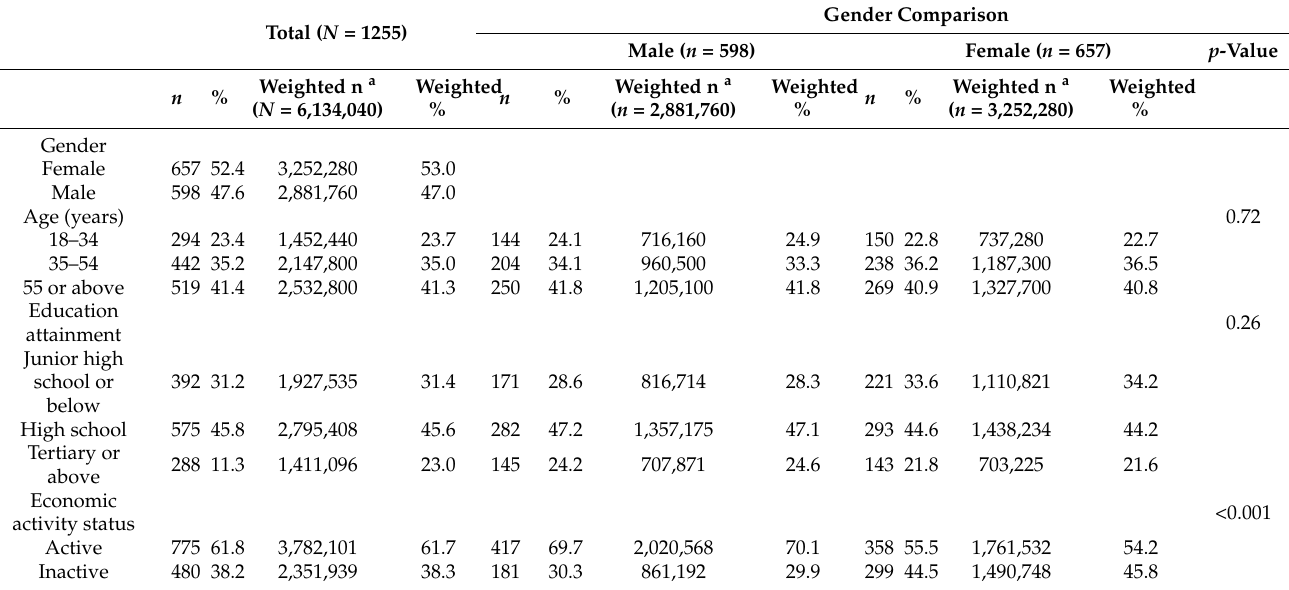
Table 1. Demographic characteristics among study